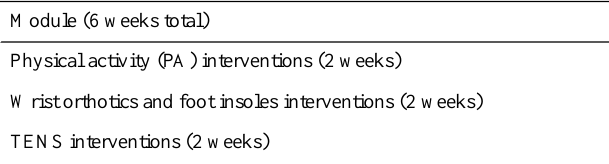
Table 1. Facebook Plus (Group E) module including health care professionals. ModeratorModule (6 weeks